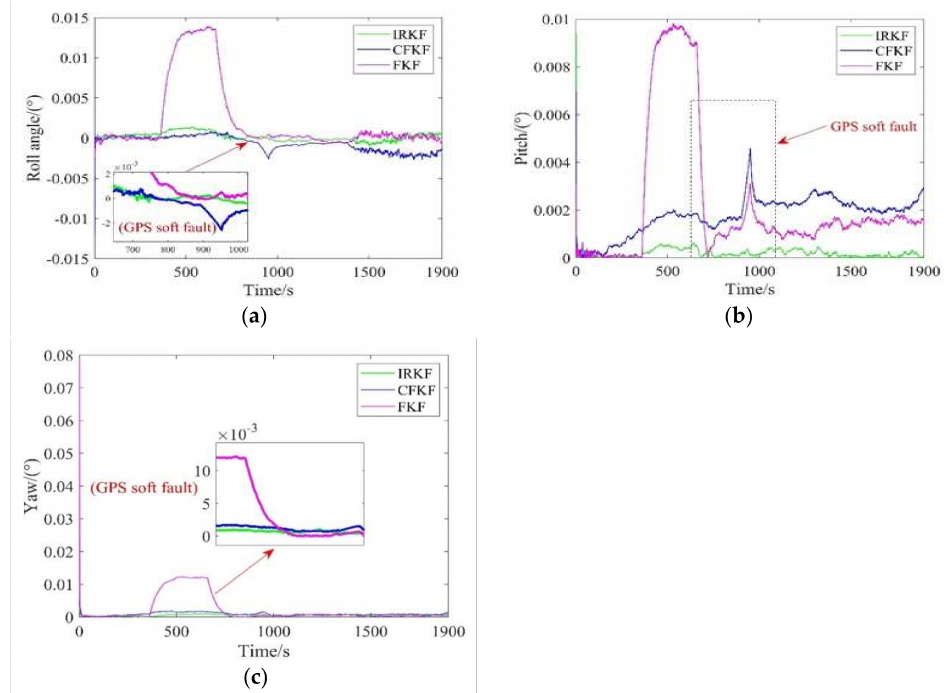
Figure 9. Estimation error of attitude. ( a ) Estimation error of roll angle. ( b ) Estimation error of pitch angle. ( c ) Estimation error of yaw angle.